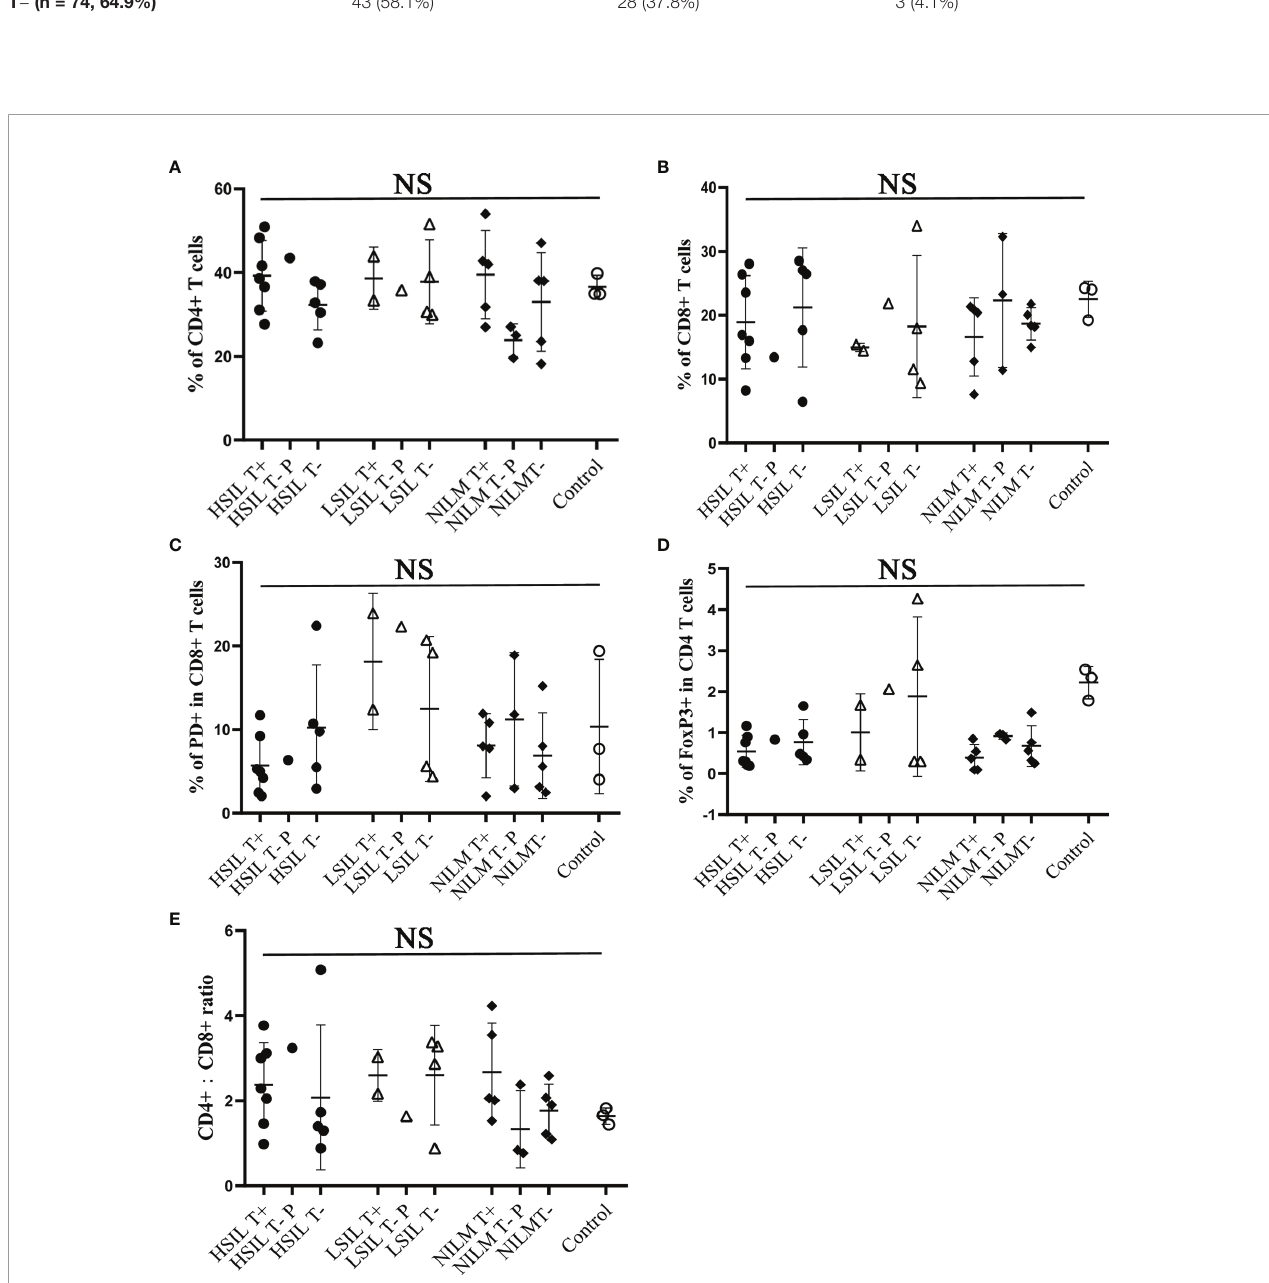
FIGURE 3 | Flow cytometric analysis of CD8, CD4, CD4/CD8 ratio, PD-1 and FoxP3 from peripheral blood CD3 + T cells of HPV 16 infected cohorts. In total 32 patients were analyzed. (A, B) Frequency of CD8 or CD4 expression on CD3 + T cells. (C) Frequency of PD-1 expression on CD8 + /CD3 + T cells. (D) Frequency of FoxP3 expression on CD4 + /CD3 + T cells. (E) CD4:CD8 ratio. T+, sample with positive HPV16-speci fi c T cell response; T − , sample with negative HPV16-speci fi c T cell response; P, persistent HPV16 infection; Control, samples from 3 women with no history of HPV16 infection. NS, no signi fi